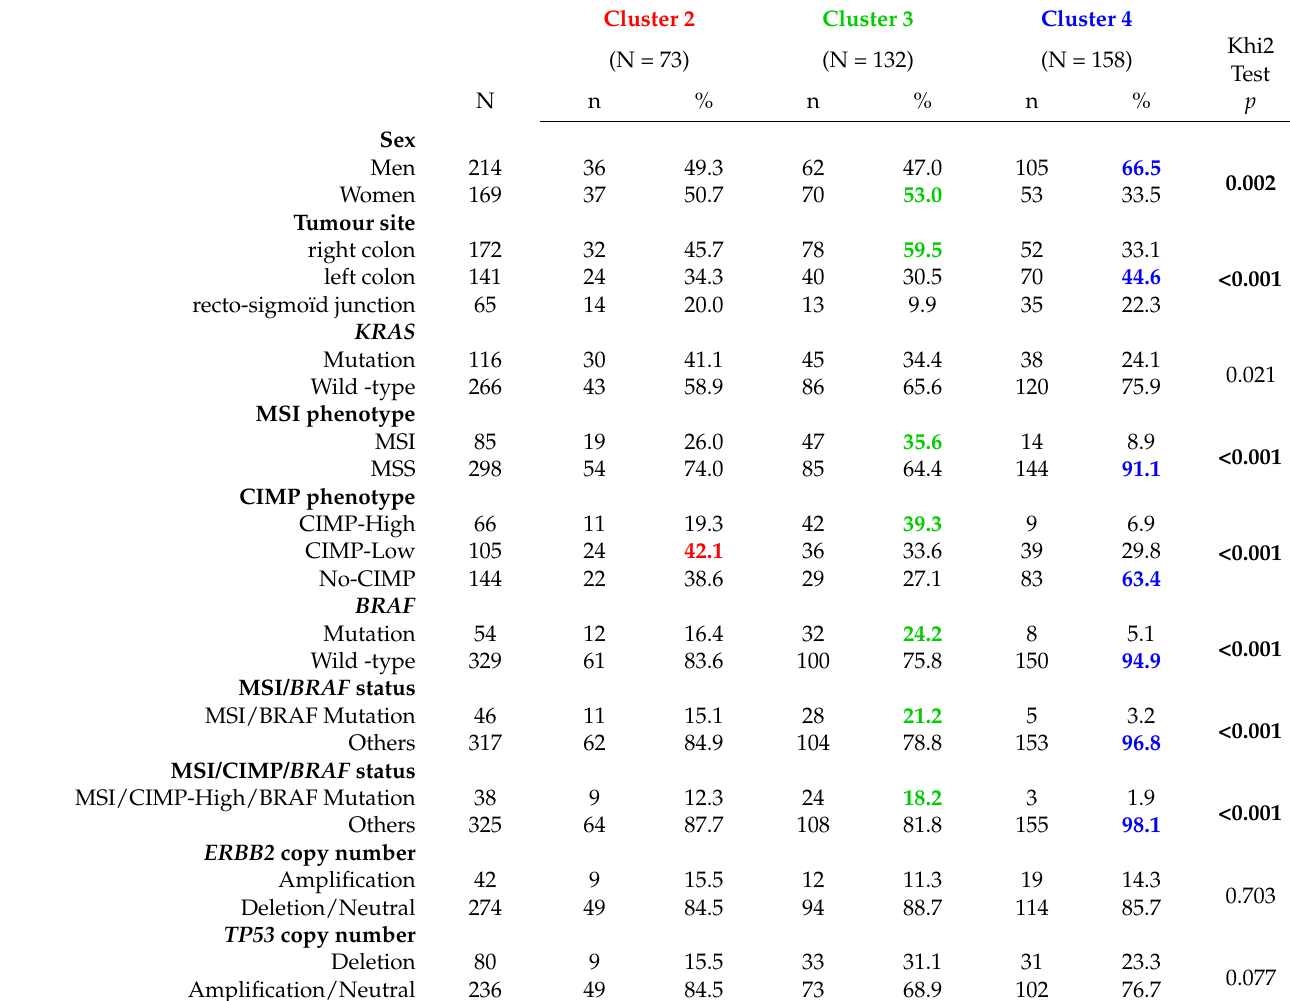
Table 2. Clinical and molecular associations with DNA methylation clusters in the population-based discovery cohort of stage II